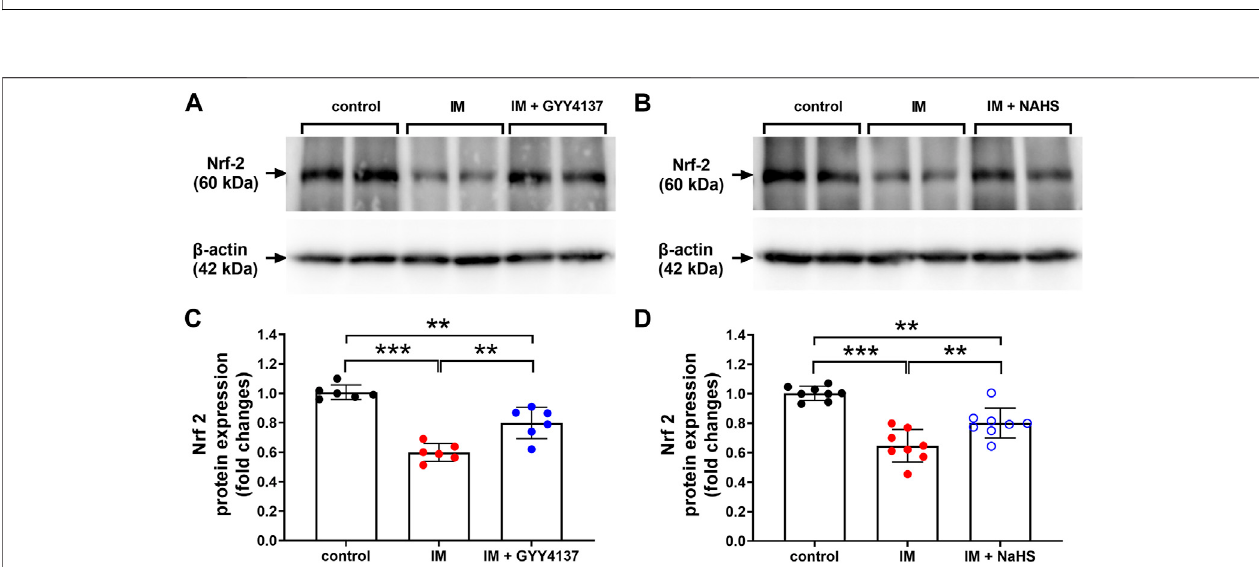
FIGURE 9 | H2S donors improve the IM-induced changes in NRF2 protein expression in skeletal muscle. Mice were subjected to IM and treated with GYY4137 (a and c, 50 μ g/kg/d, ip), or NaHS (b and d, 1.12 mg/kg, twice a day, ip) for 2 weeks. The control and IM groups received identical doses of saline for 2 weeks. (A) & (C) , NRF2 protein expression by Western blot analysis of TA muscle in control, IM, and IM + GYY4137 mice (n = 6 in each group). (B) & (D) , NRF2 protein expression by Western blot analysis of TA muscle in control, IM, and IM + NaHS mice (n = 8 in each group). Data represent means ± SEM. * p < 0.05, ** p < 0.01, *** p < 0.001.